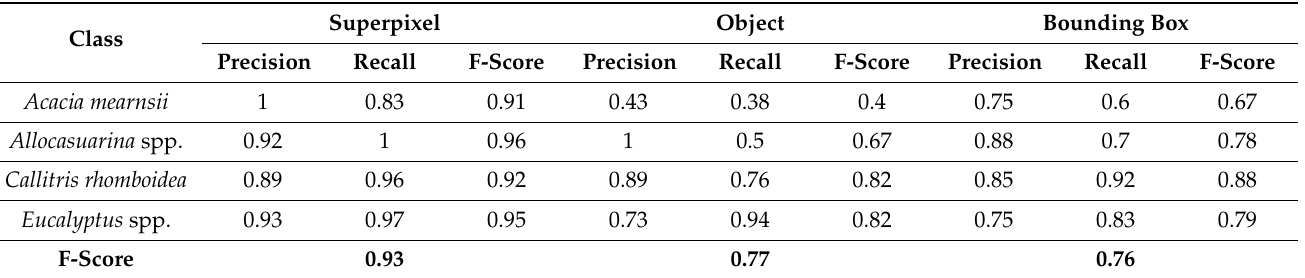
Table 7. Class-specific accuracies: Precision, Recall and F-score with grouped Eucalyptus